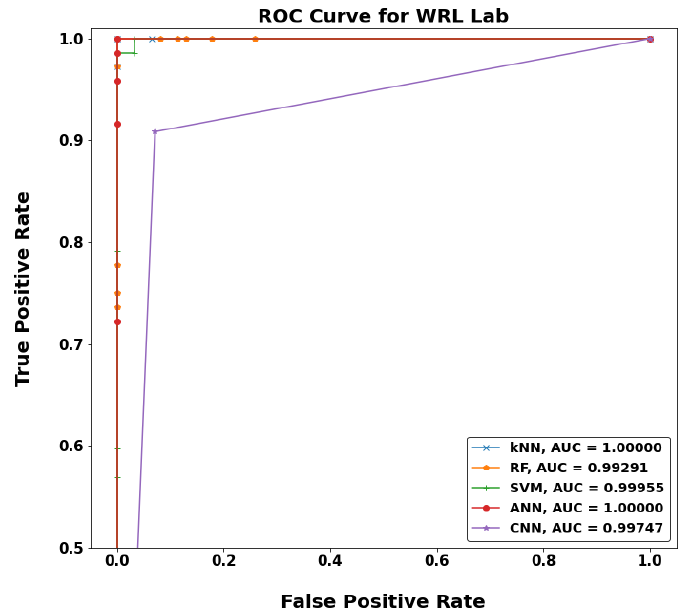
Figure 20. ROC curves for WF-ML models in WRL Lab.